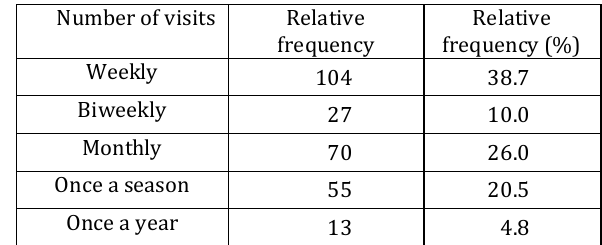
Table 8. Frequency visits to the forest